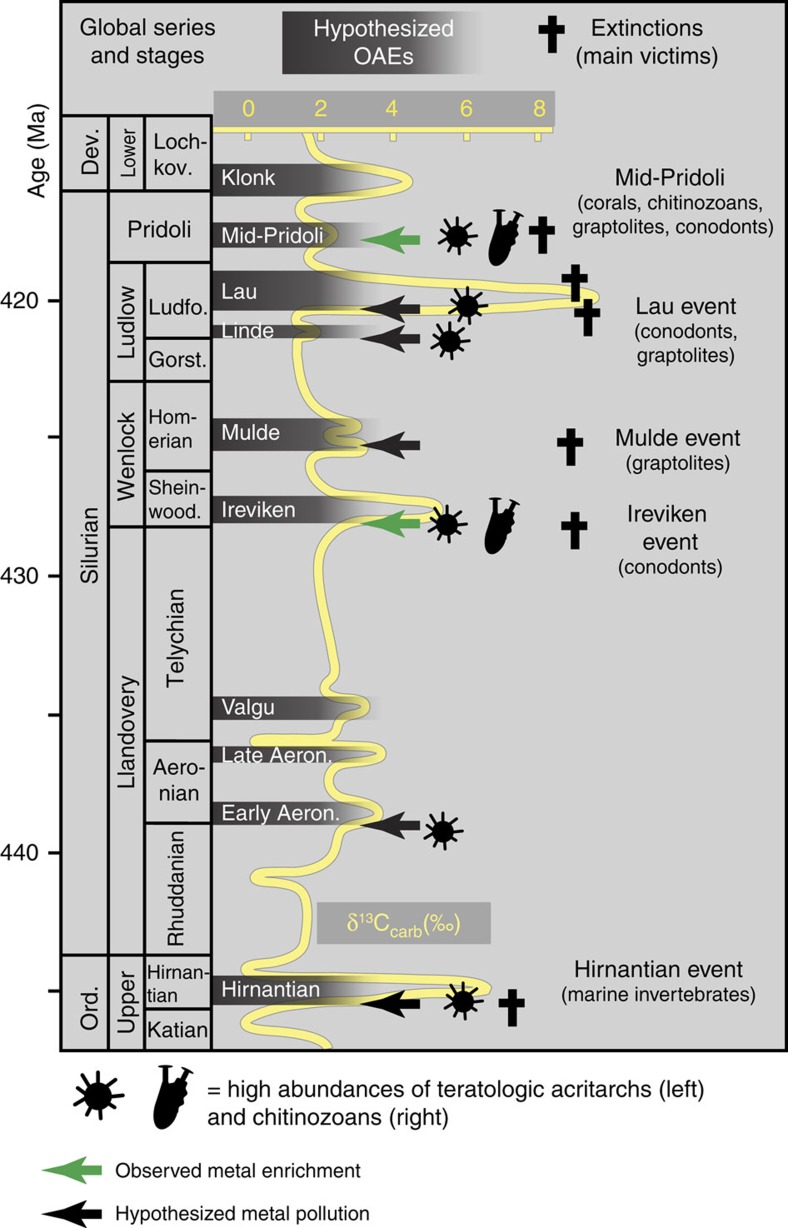
Distribution of potential OAEs in the uppermost Ordovician and Silurian.The position of the suggested OAEs is based on δ13C stratigraphy34. Key victims of the extinction events and the events with increased occurrences of teratology are highlighted13. Metal toxicity is observed in the Pridoli (this study) and implied during the Ireviken event, where metal enrichments in carbonates and phosphates in SE Sweden indicate anoxia12. For a full list of affected fauna see Kaljo et al.33 and Calner6. Ord., Ordovician; Dev., Devonian.